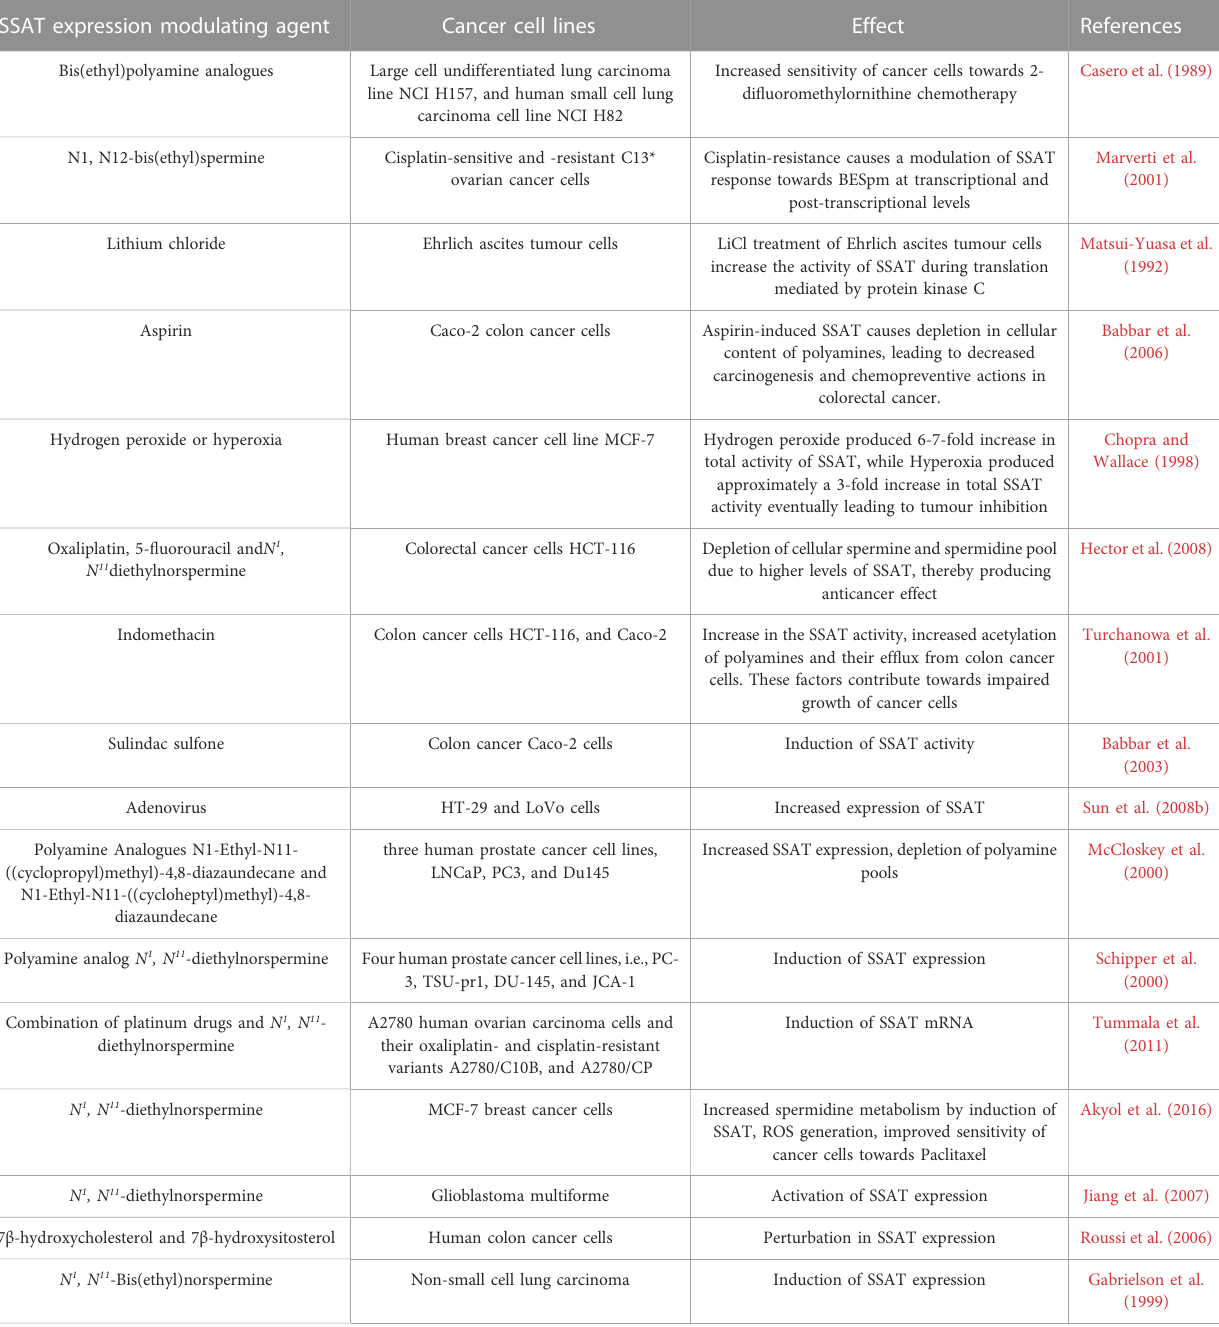
TABLE 1 The role of modulated SSAT enzyme expression in the regulation of chemotherapy resistant/sensitive cancers. SSAT expression modulating